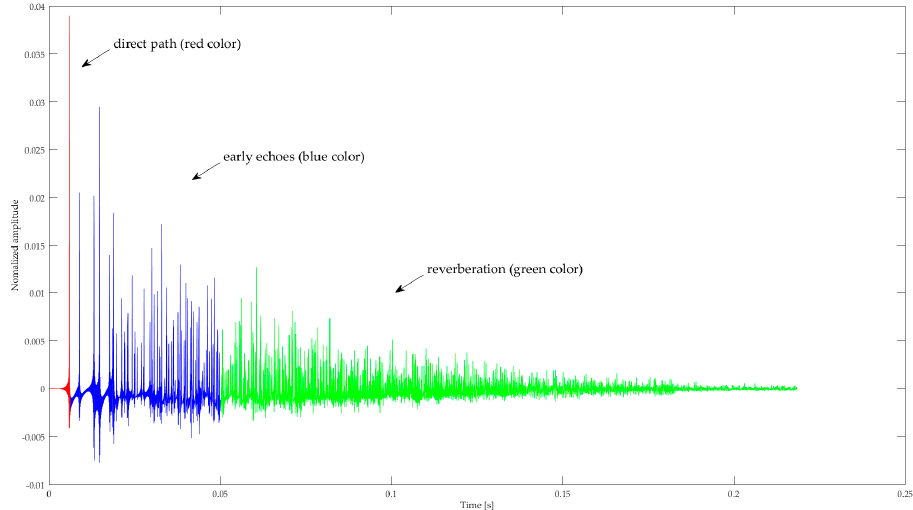
Figure 5. The real room impulse response (RIR) for the RT 60 of 500 ms.